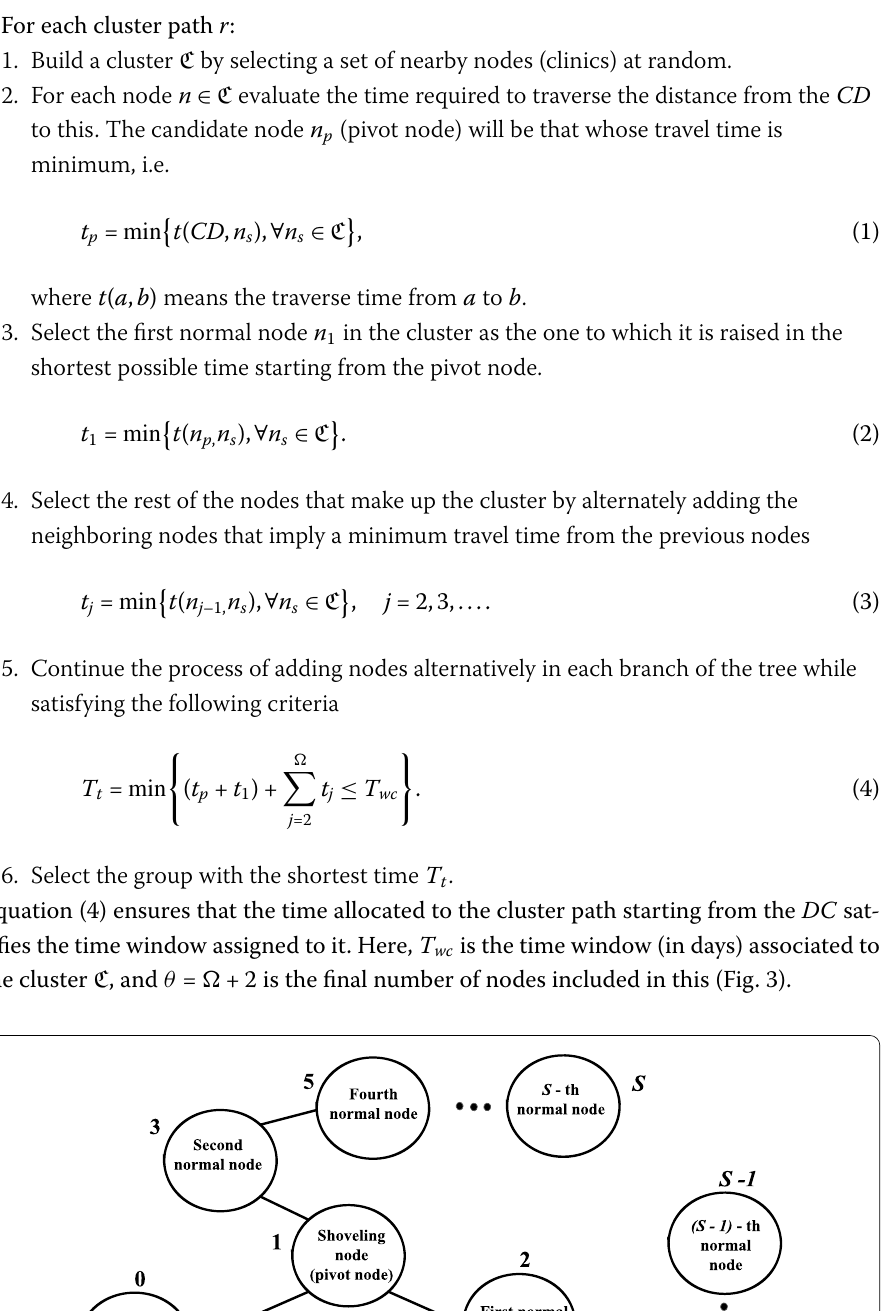
Algorithm 1 (Modified Dijkstra algorithm) To use this algorithm it will be assumed that it is known the time t required to travel the distance d using route r . The algorithm is as follows.